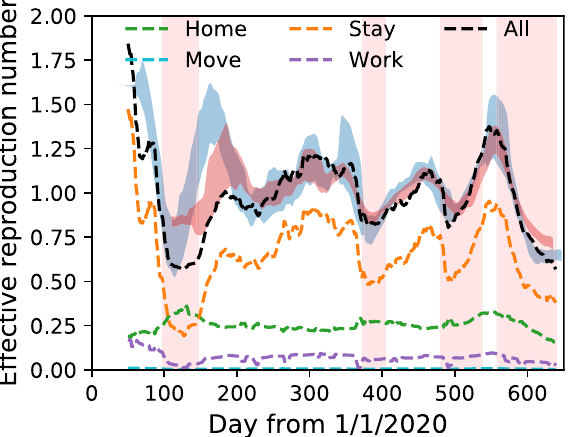
Figure 5. Components of effective reproduction number in the model. Empirical data are indicated by blue and red bands for all infections and severe cases, respectively. The stay-out activity gives the largest component in most time